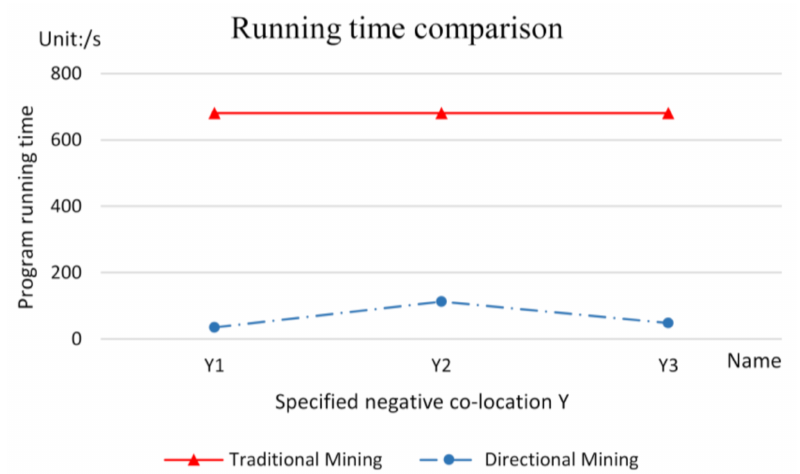
Figure 9. Comparison of running times between traditional mining and directional mining under different numbers of features.